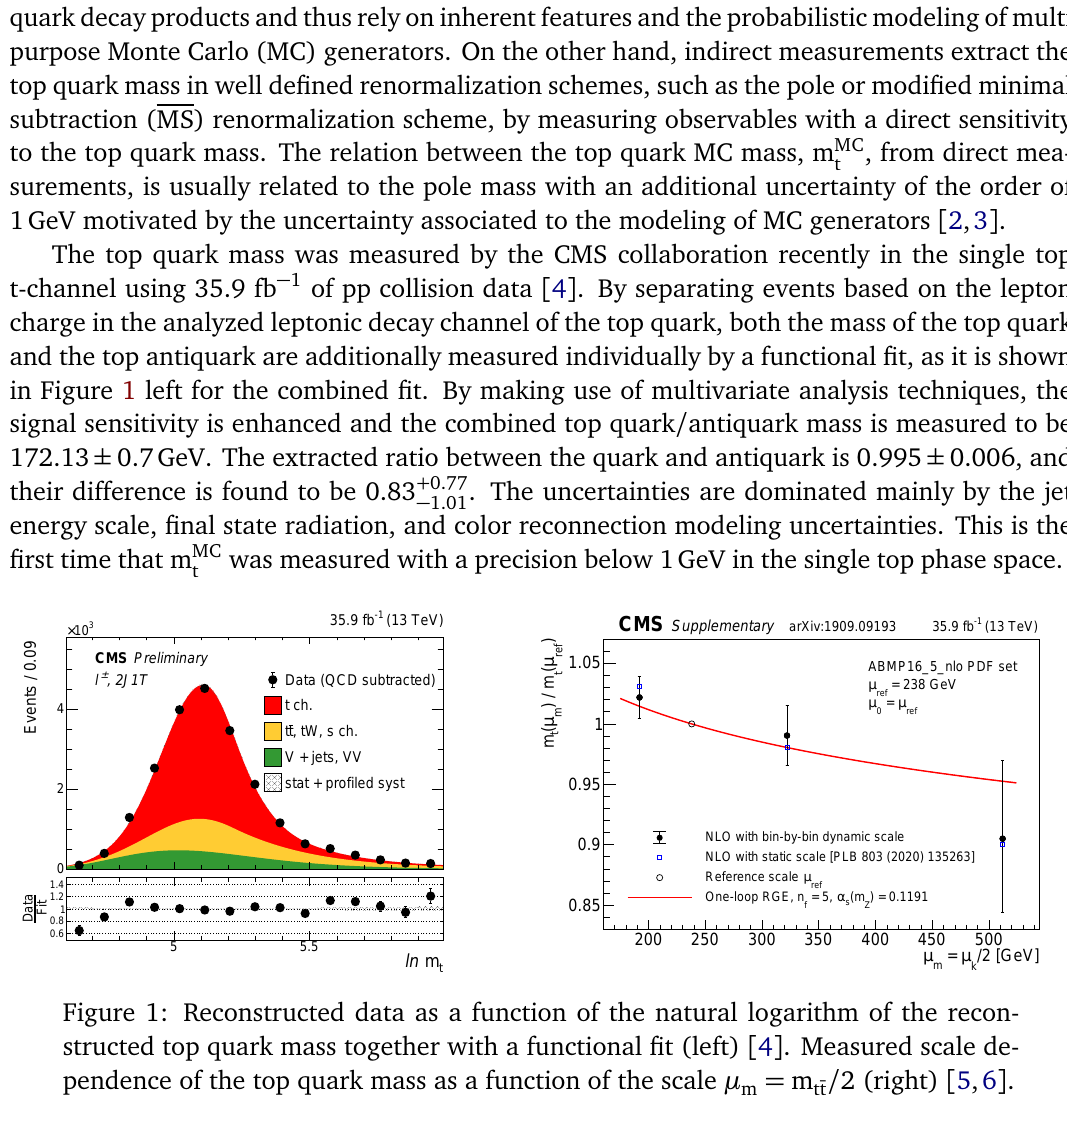
= m / 2 (right) [ 5,6 ] t¯t m